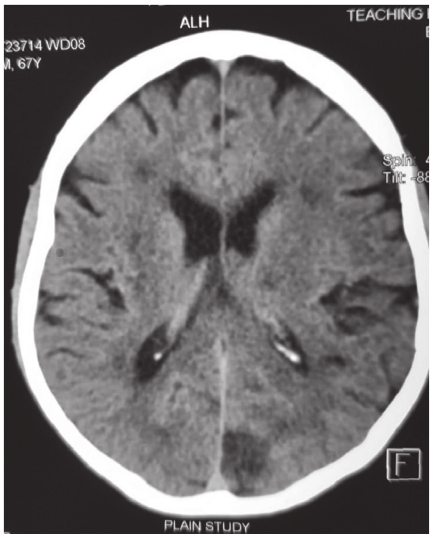
Figure 2: Noncontrast CT scan of the brain showing bilateral watershed infarctions in the fronto-parietal regions and a right- sided occipital